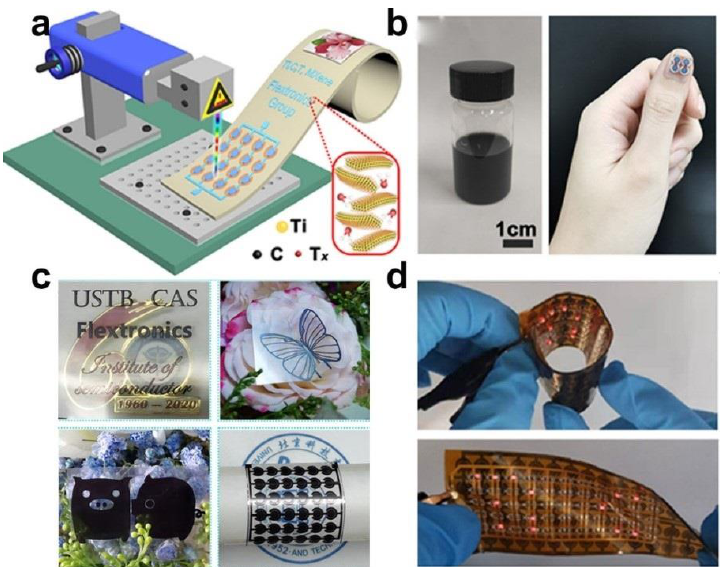
Figure 8. Schematic illustration of the laser direct writing process for fabricating the flexible on-chip MSCs. ( a ) The schematic diagram exhibiting the fabrication process; ( b ) Digital photos of the Ti 3 C 2 T x supernation and the fabricated micro device array directly attached to the fingernail; ( c ) Optical images of the laser written MSC array; ( d ) Digital images of the Ti 3 C 2 T x based Zn-ion MSC array powering a flexible LED array of the “TiC” logo under different deformations. The figure has been reproduced with permission from Springer Nature [62].